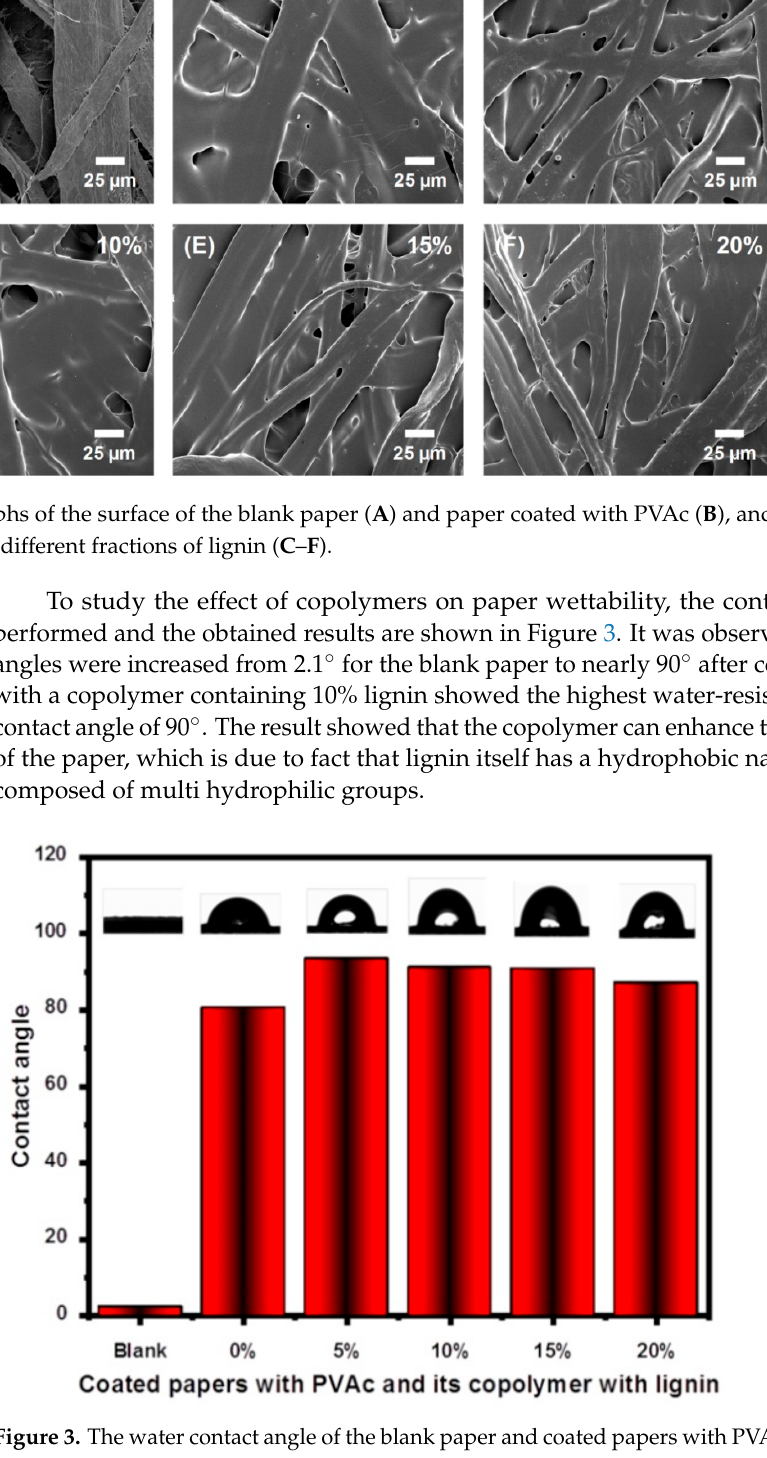
Figure 3. The water contact angle of the blank paper and coated papers with PVAc and its copolymers containing different lignin fractions.